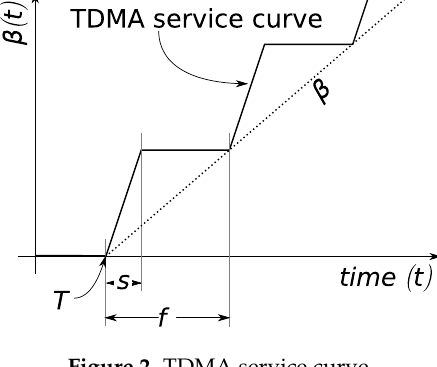
Figure 2. TDMA service curve.